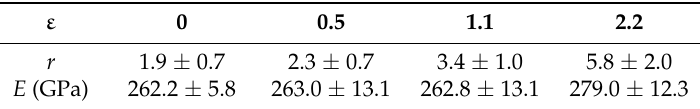
Table 3. Values of the length/width aspect ratio of the grains, r , and Young’s modulus, E , measured along the rolling direction as a function of the groove rolling strain, ε